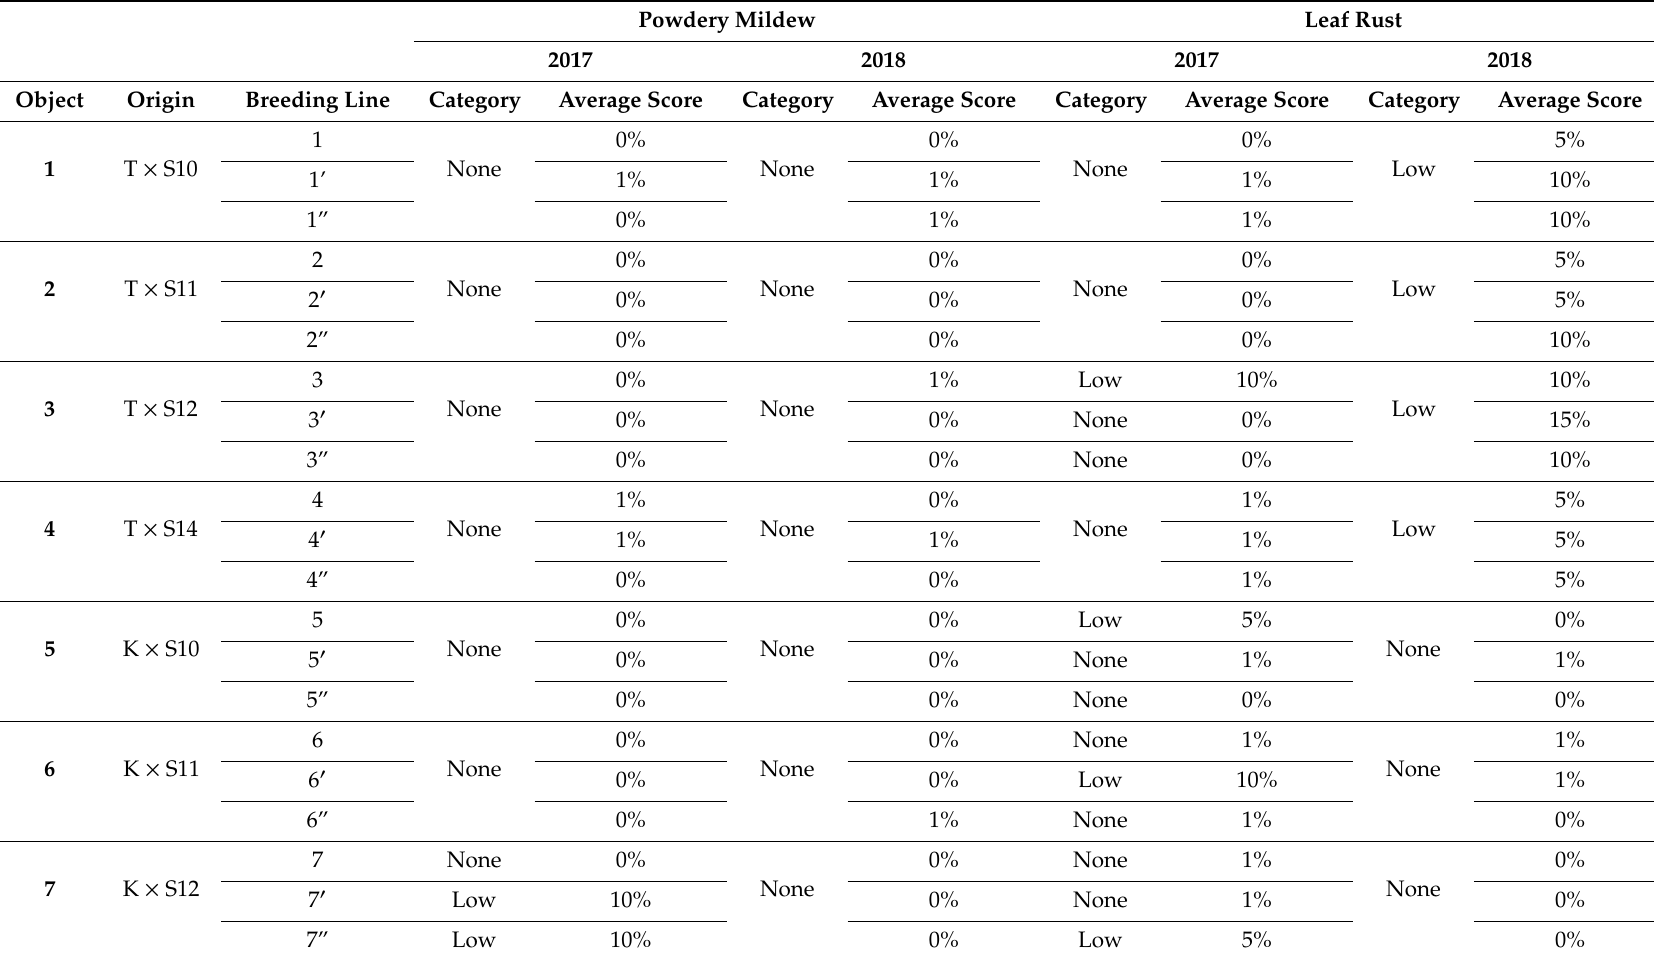
Table 4. The health status of the investigated wheat accessions in two experimental years (2017 and 2018). Powdery Mildew Leaf